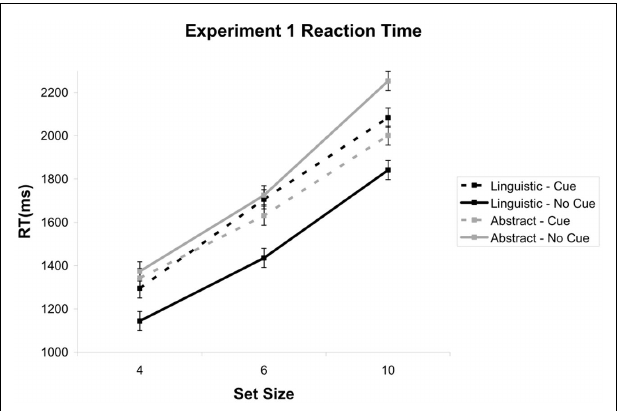
FIGURE 2 | Reaction time data for Experiment 1, combined over target present and target absent trials. Confidence intervals in the figure were calculated using the three-way interaction (Loftus and Masson,